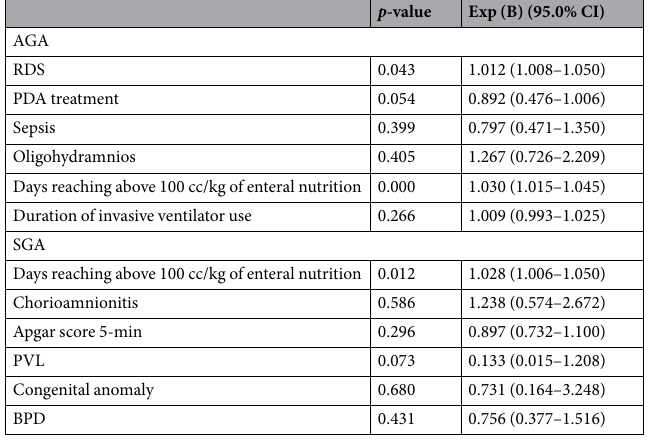
Table 4. Risk factors for postnatal growth failure for the small for gestational age (SGA) and appropriate for gestational age (AGA) groups. AGA, appropriate for gestational age; RDS, respiratory distress syndrome, SGA, small for gestational age; PVL, periventricular leukomalacia; BPD, bronchopulmonary